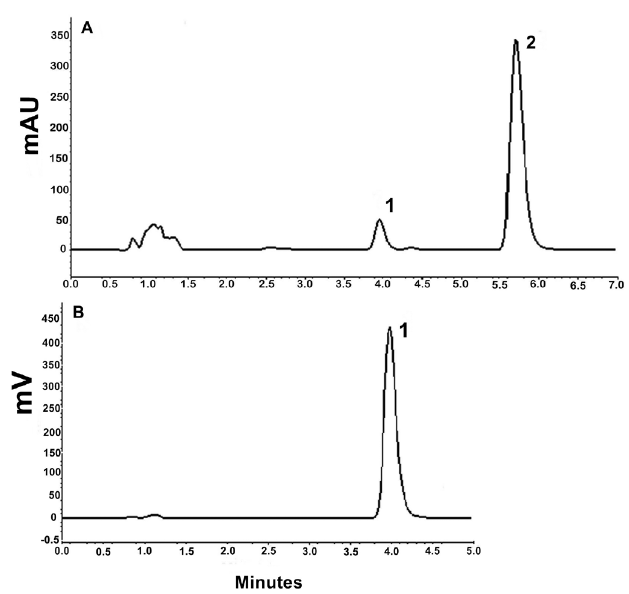
FIGURE 2 - Chromatograms of standard solutions. HPLC-UV detection at 200 nm (A), and HPLC-Fluorescence detection at λ =280 nm and λ =310 nm (B). Concentration: 5.00 µg.mL -1 ex em of ethinyl estradiol (1) and 750.00 µg.mL -1 of drospirenone (2). Chromatographic conditions: LiChroCART ® column (125 mm x 4 mm i.d., 5 µm particle size), mobile phase: acetonitrile:water (50:50 v/v), flow rate 1.0 mL.min -1 , injection volume: 20 µL, temperature 25 ± 1 °C.